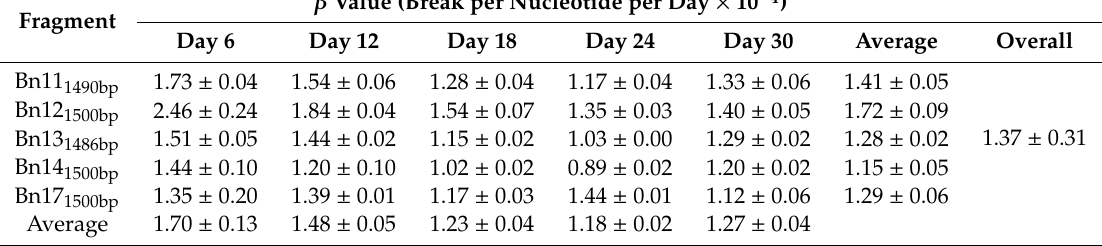
Table 3. Estimated β values for five canola mRNA fragments of similar length in the AA seeds of di ff erent aging